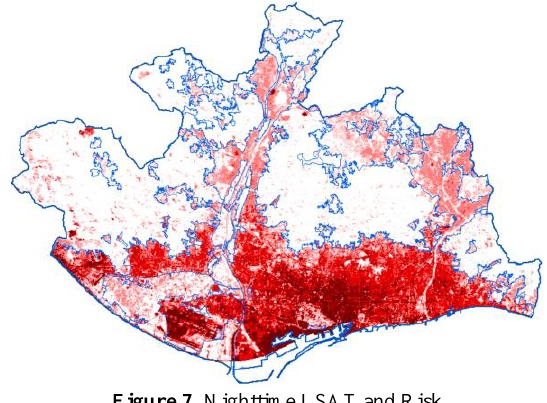
Figure 7. Nighttime LSAT and Risk